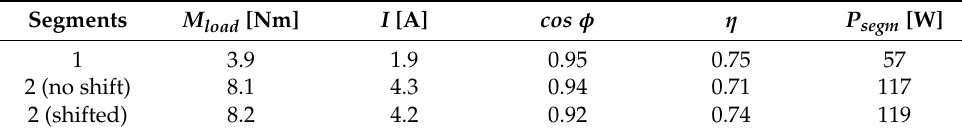
Figure 10. Results of tentative experimental evaluation of the developed segmented motor: ( a ) cogging moment dependence from rotational angle for one and two arc-shaped elements with shift angle, ( b ) instantaneous voltage and current of a single arc-shaped segment at rated parameters, ( c ) power factor as a function of motor load. Table 4. Numerical Test Results of Motor